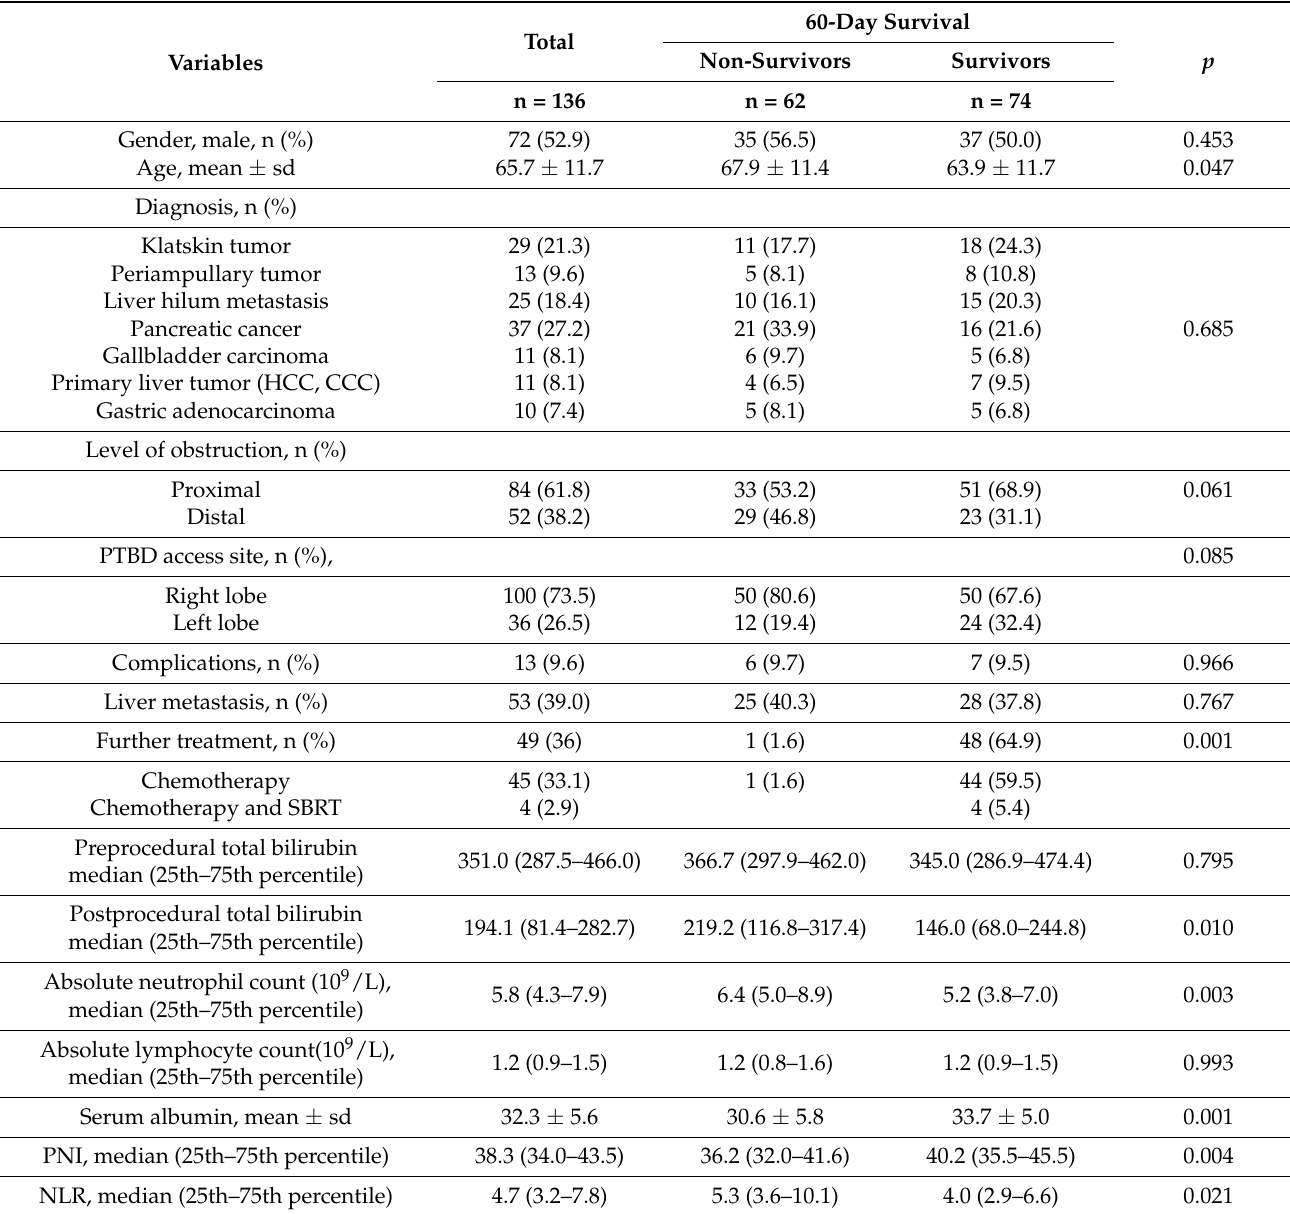
Table 1. Demographic and clinical characteristics of study population, overall and according to the survival